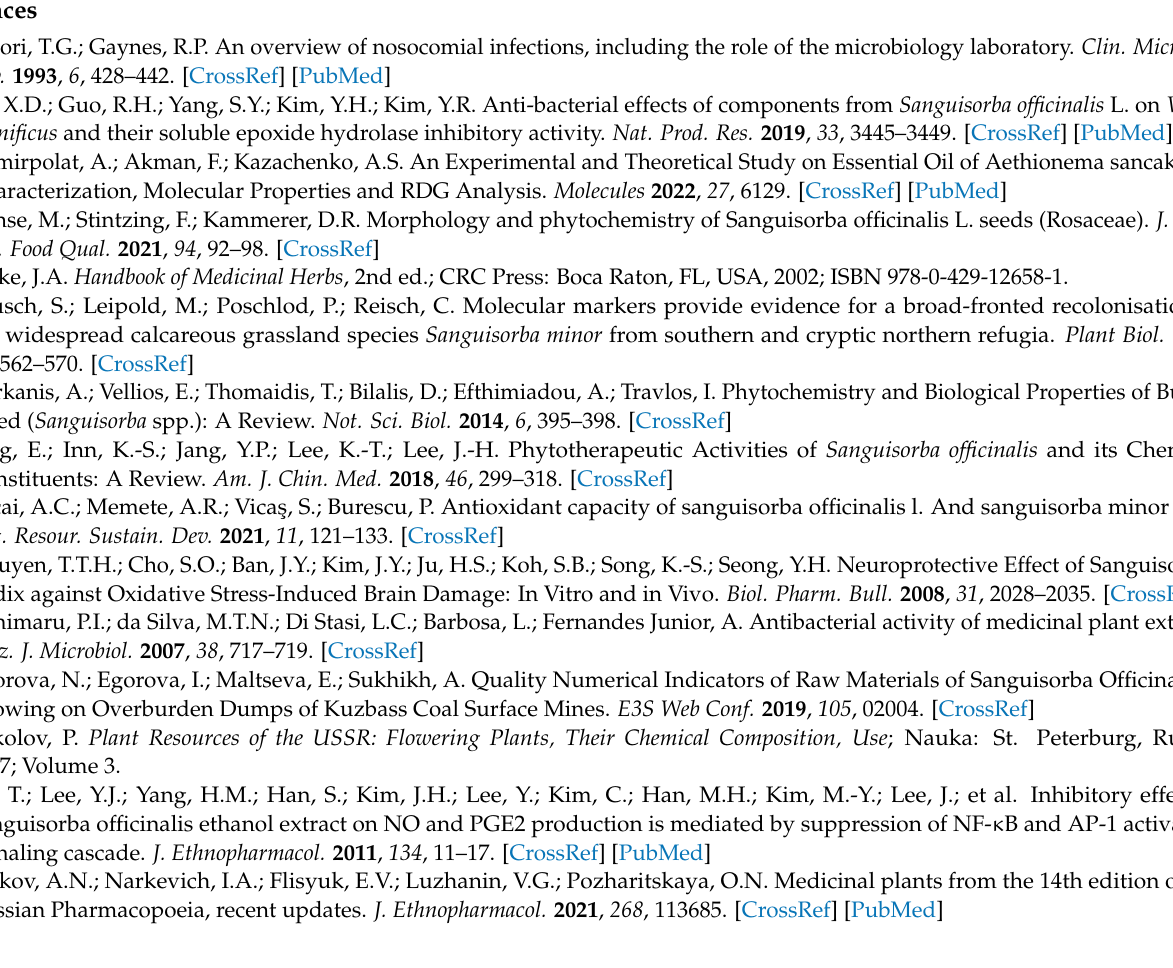
Figure S2: HPLC cromatograms of Sanguisorba minor Scop., ( a ). SMR- S. minor Scop. roots; ( b ). SML- S. minor Scop. leaves; ( c ). SMF- S. minor Scop. flowers; Table S1. Antimicrobial activity of antibiotics against gram (+) ( S.aureus ) and gram ( − ) bacteria strains ( E. coli and P. aeruginosa ) expressed as diameter of inhibition zone